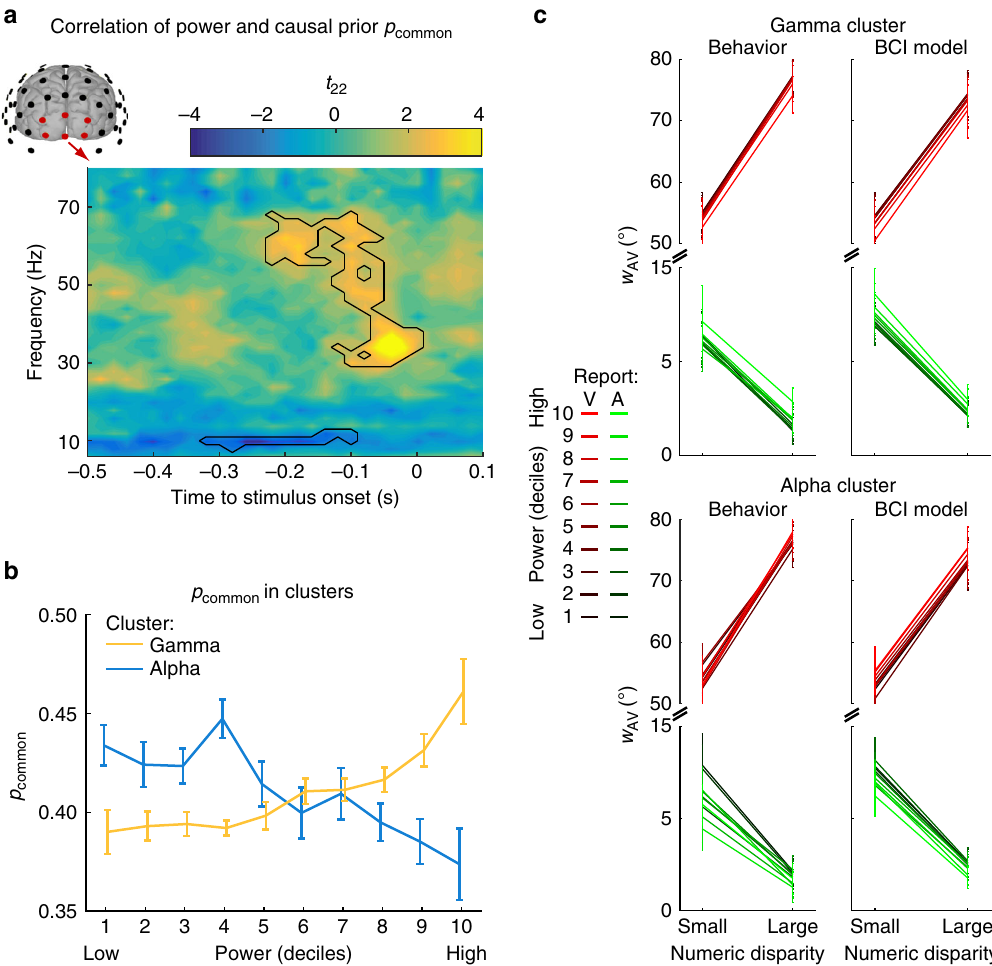
Fig. 5 Effect of prestimulus oscillatory power on the BCI model ’ s causal prior ( p common ) over occipital electrodes. a Time-frequency t -value map ( n = 23) for the correlation between p common and the oscillatory power deciles averaged across occipital electrodes. Signi fi cant clusters ( p < 0.05; two-sided cluster- based corrected randomization t 22 test) are demarcated by a solid line. b p common (across-participants ’ mean ± within-participants ’ SEM) as a function of power deciles averaged across the signi fi cant clusters in the gamma and alpha band shown in a . c The weighting index w AV (across-participants ’ mean and bootstrapped 68% CI) computed from participants ’ behavior (left column) and the BCI model ’ s predictions (right column) for each of the 10 power deciles shown in b . w AV is shown as a function of numeric disparity (small: ≤ 1 vs. large: ≥ 2) and task relevance (A: auditory vs. V: visual report), separately for the signi fi cant cluster in the gamma (top) and alpha band (bottom). w AV = 90° for purely visual and w AV = 0° for purely auditory in fl uence. Source data